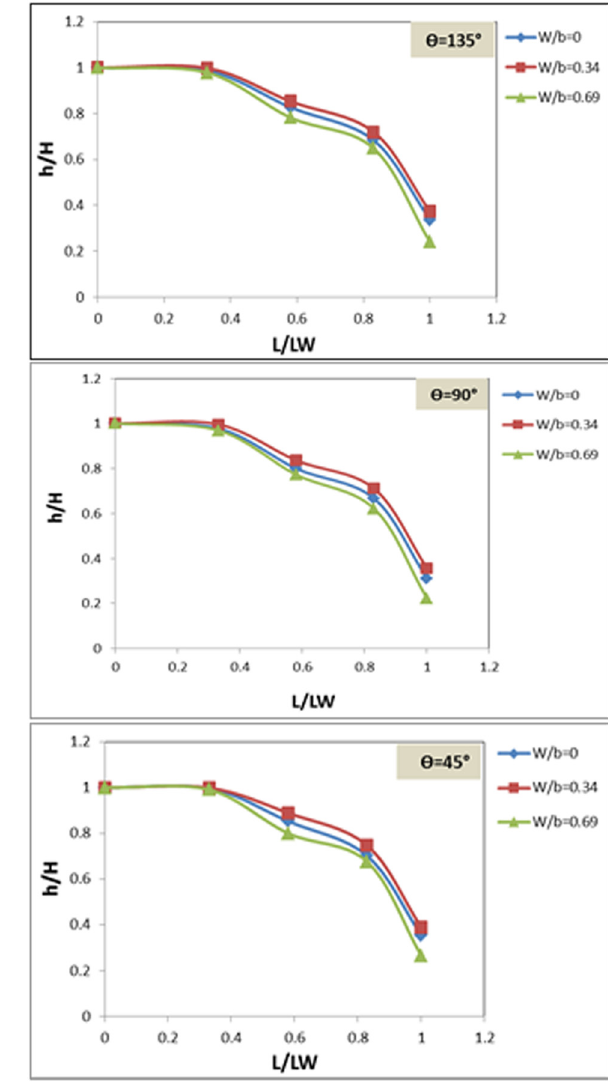
Figure 6: In fl uence of void width on head pressure of the points for three angles of cuto ff .